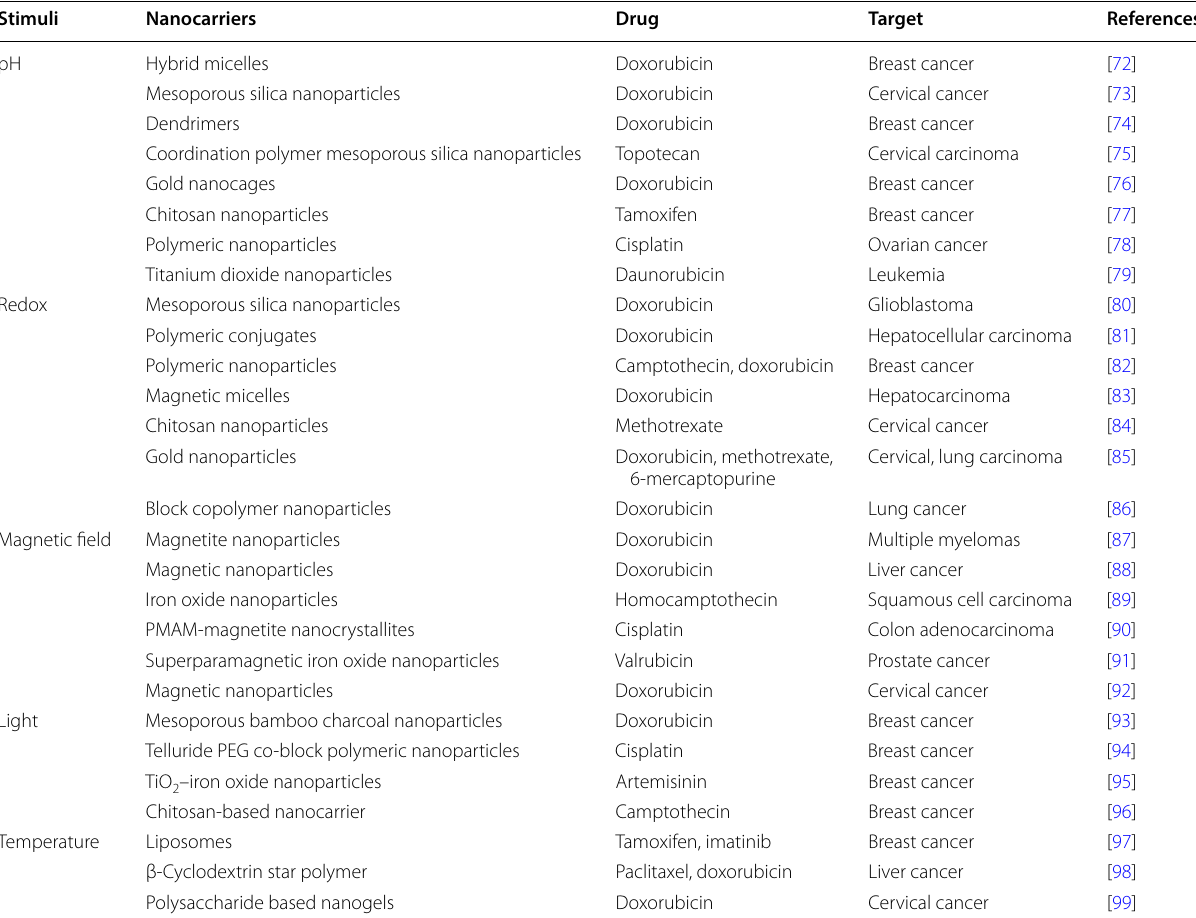
Table 1 The stimuli-responsive release of drugs loaded on different nanocarriers